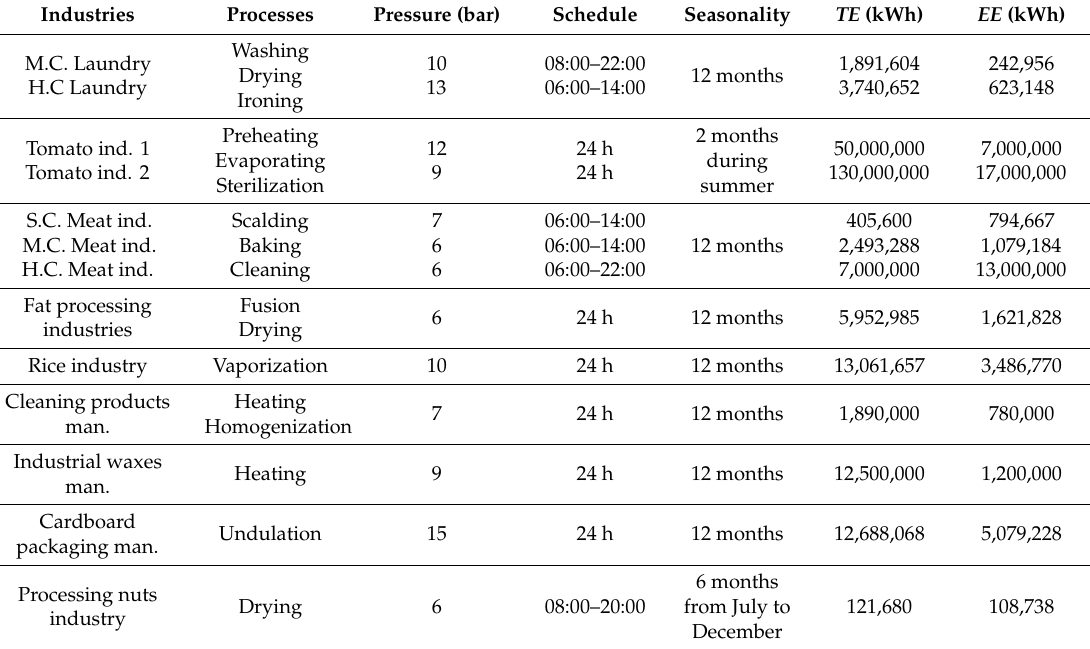
Table 4. Data from studies to